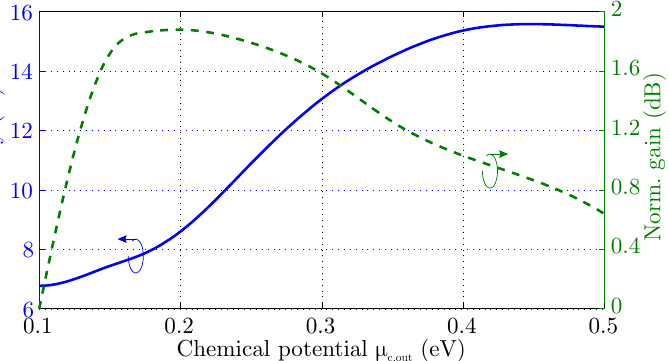
Figure 8. Radiation efficiency and normalized gain at the direction of desired propagation for different chemical potential values of the matching component.